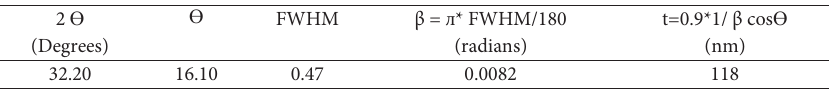
Table 1. Determination of crystalline size of silver nanoparticles using Debye Scherrer’s equation. 2 ϴ